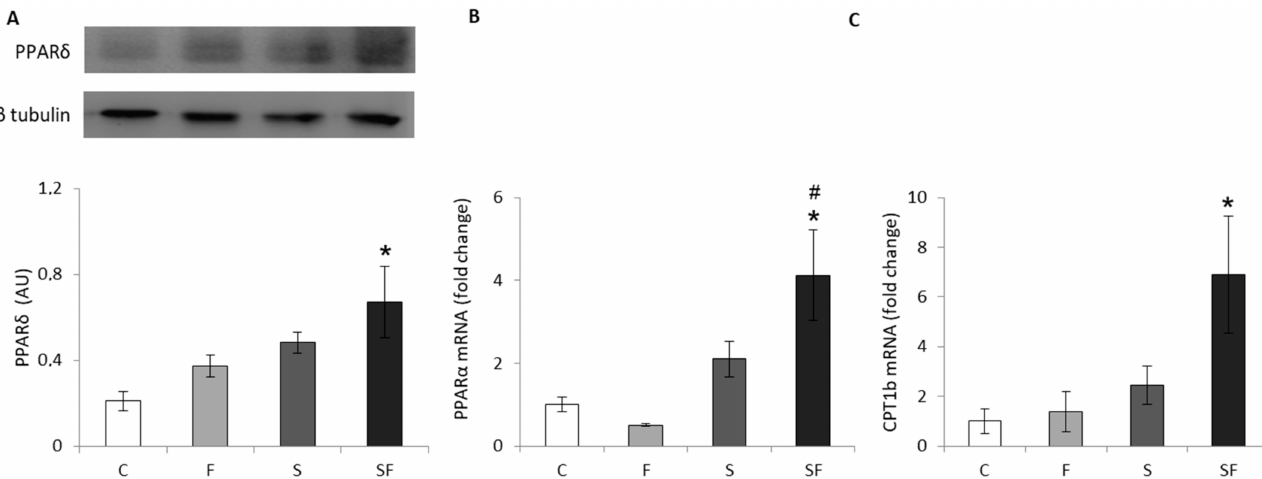
Figure 2. Level of PPAR δ ( A ), PPAR α ( B ) and CPT1b ( C ) in skeletal muscle of control (C), fructose (F), stress (S), and stress + fructose (SF). Protein level of PPAR δ (normalized to β -tubulin) was measured by Western blot in the muscle tissue extracts. The values represent the mean ± SEM. PPAR α and CPT1b mRNA levels compared to HPRT mRNA were determined by SYBR ® Green real-time PCR in the skeletal muscle. The values represent the mean ± SEM ( n = 8–9 animals per group). All measurements were done in triplicate. Significant between-group differences from post hoc Tukey test are given as follows: * p < 0.05, SF vs. C; # p < 0.05, SF vs. F. PPAR δ —peroxisome proliferator-activated receptor- δ